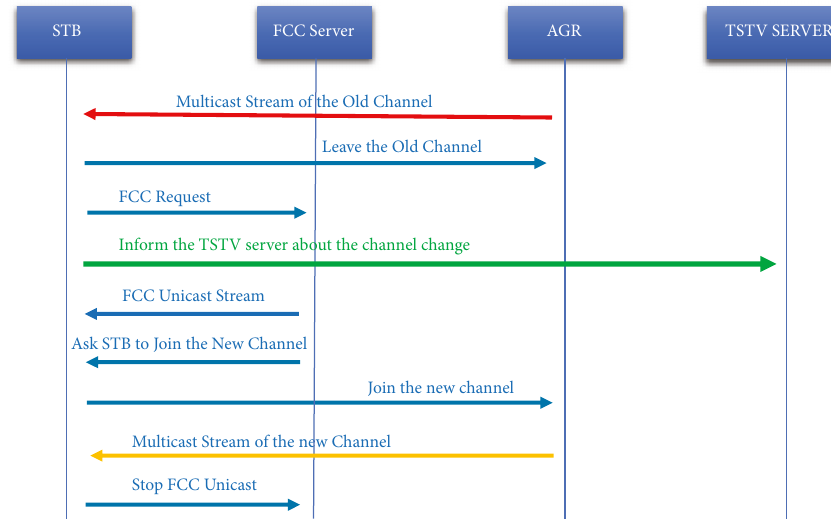
Figure 7: TSTV database update mechanism.